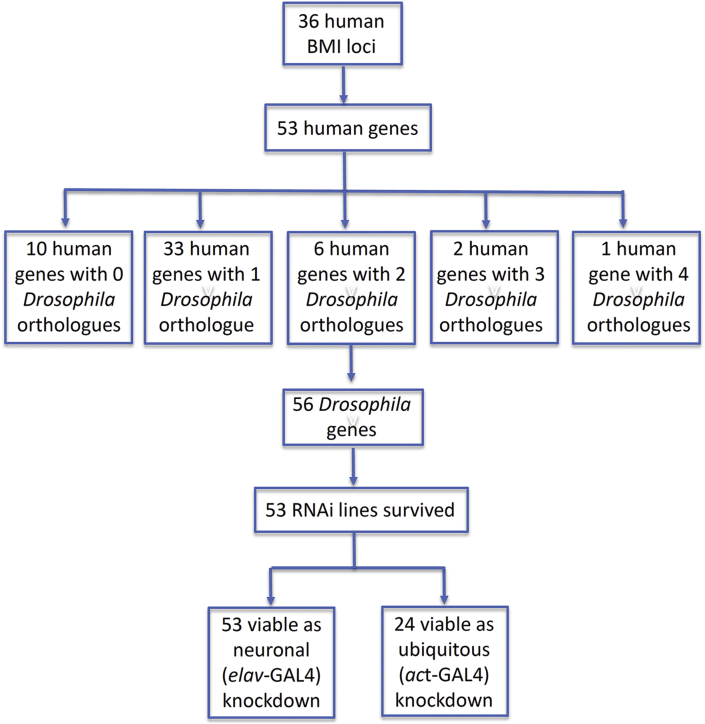
Selection of BMI GWAS genes.